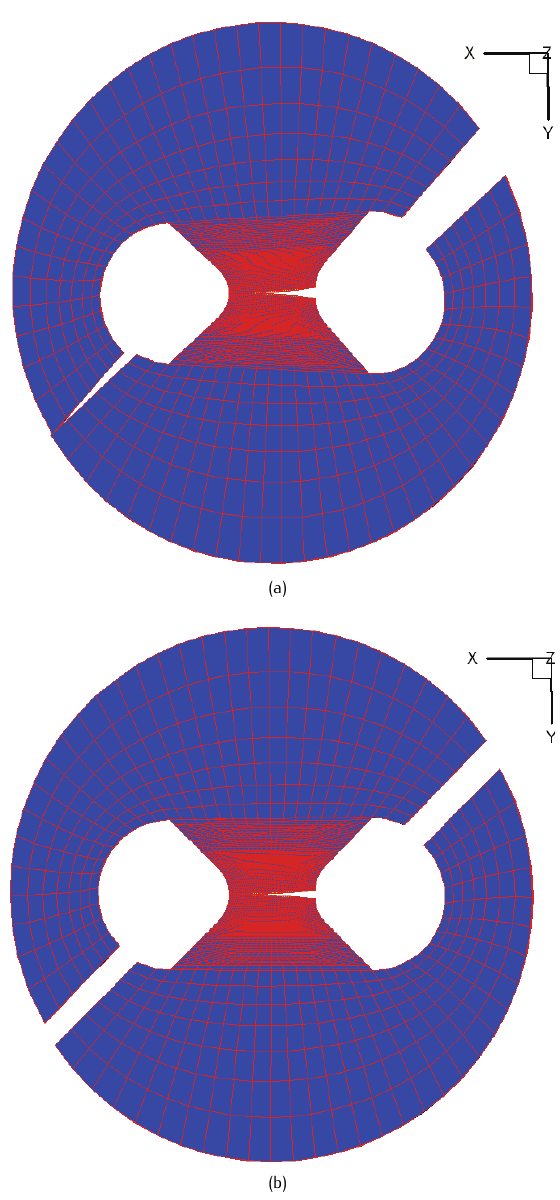
Figure 8. The fixture and specimen response in the different loading velocity (a) 6 . 0 × 10 +01 (b) 6 . 0 × 10 +02 during same crack extension